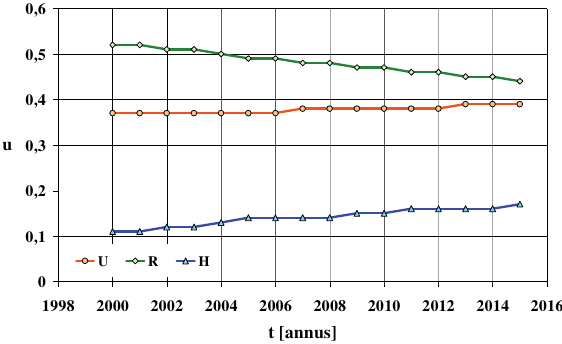
Fig. 3. Mileage of passenger cars under the following model traffic conditions: urban, rural and on highways and expressways